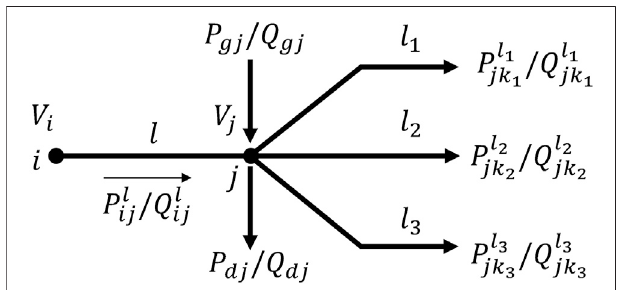
FIGURE 3 | A typical connection of radial